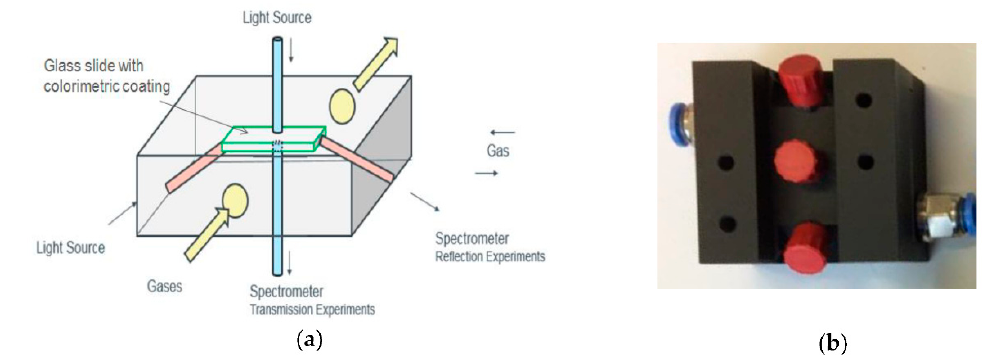
Figure 1. Experimental setup for the optical readout of colorimetric materials. ( a ) schematic depiction of the optical measurement cell; ( b ) Photograph of the combined transmission/ATR measurement cell in top view, optical connectors with red covers, gas inlet with blue